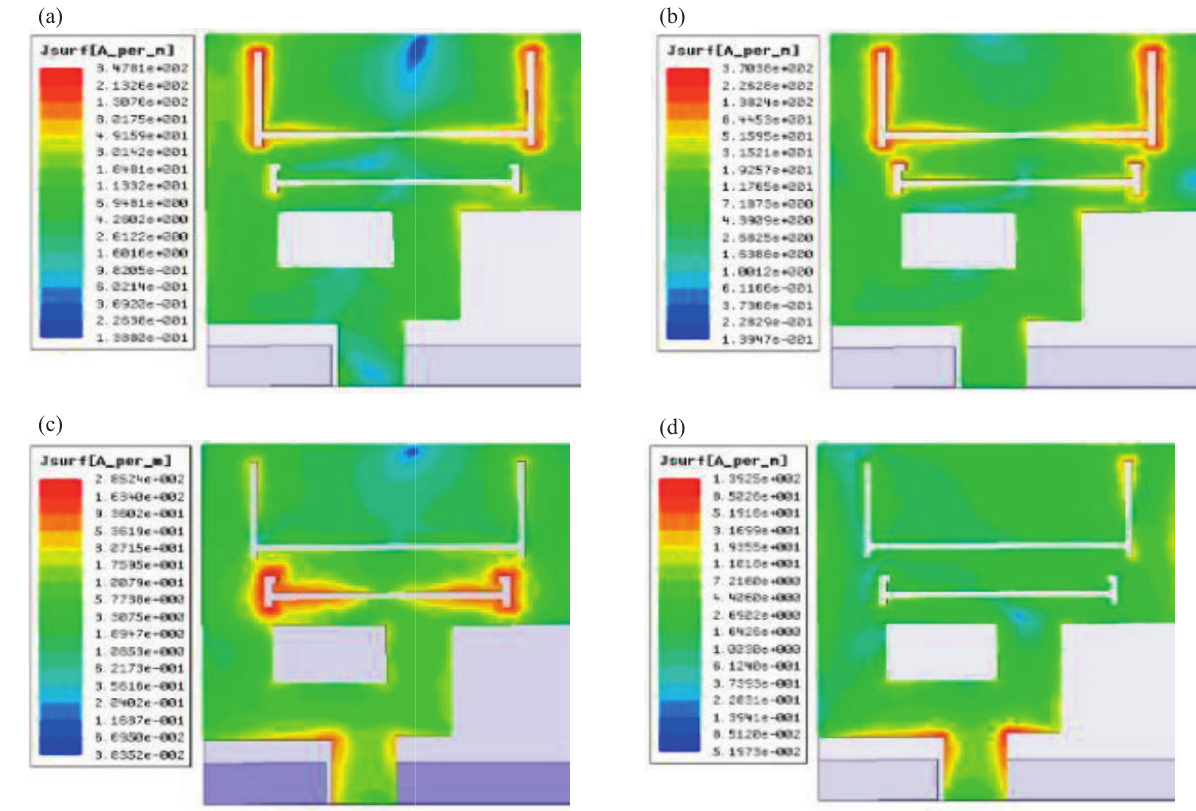
Fig. 8. Surface current distribution of (a) 3.4 GHz, (b) 5.6 GHz, (c) 6 GHz, (d) 8.6 GHz.